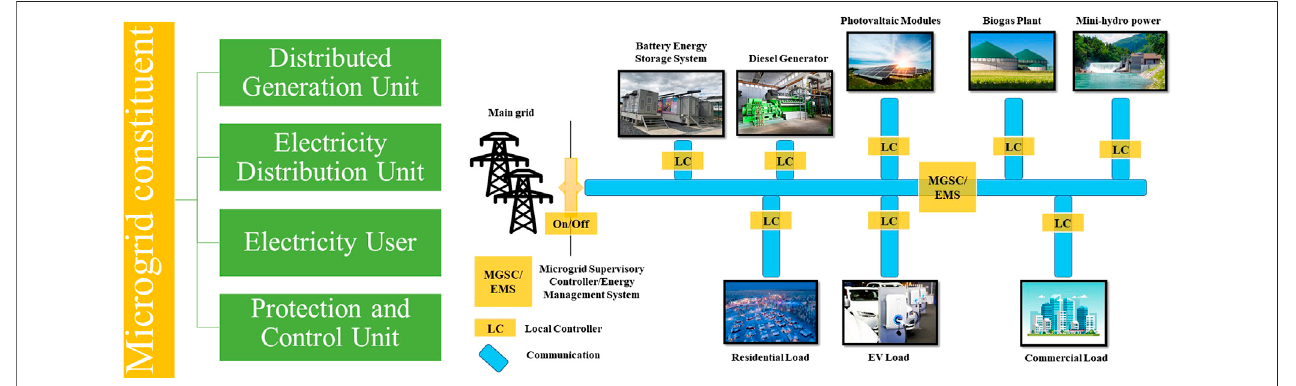
FIGURE 1 | Main microgrid